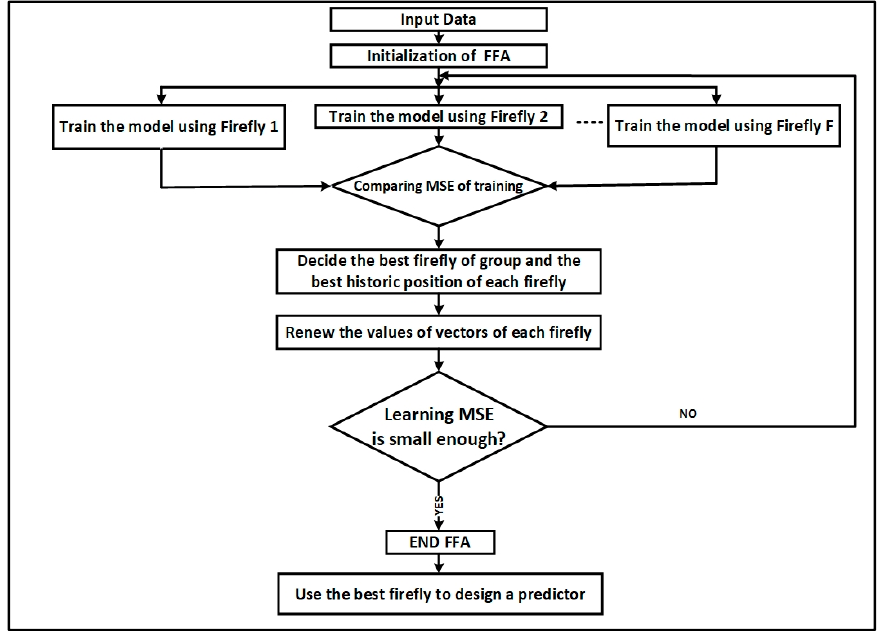
Figure 5. Designing an optimized predictor of DBN via the best firefly.